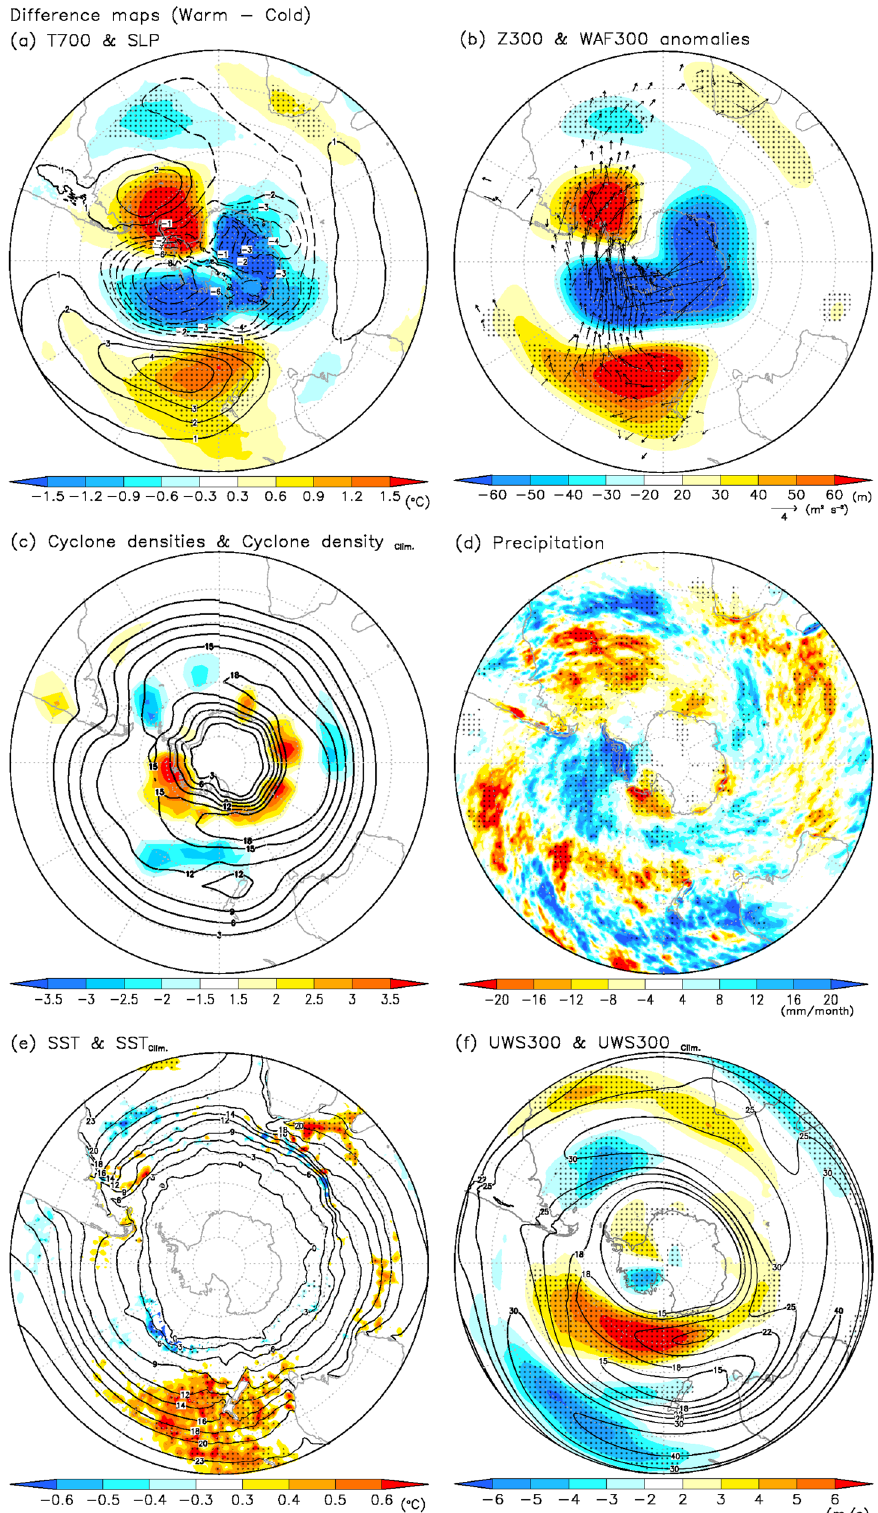
Fig. 2 Atmospheric circulation and oceanic anomalies between warm and cold AP winters over the Southern Hemisphere. Difference maps for ( a ) air temperature at 700 hPa (T700) (°C: shaded) and sea level pressure (SLP) (hPa: contours), ( b ) geopotential height at 300 hPa (Z300) (m: shaded) with the horizontal component of wave-activity fl ux anomalies (m 2 /s 2 : vector) at 300 hPa (WAF300) from ref. 53 , ( c ) cyclone density (shaded: count/S) with climatological cyclone density (count/S: contours), ( d ) precipitation (mm/month), ( e ) sea surface temperatures (SSTs) between warm and cold winters (°C: shaded) with climatological SST (°C: contours) and ( f ) U-wind speed at 300 hPa (UWS300) (m/s: shaded) with climatological UWS300 (m/s: contours) for 1979 – 2019 between warm and cold AP winters. Dotted areas denote signi fi cant differences exceeding the 95% con fi dence